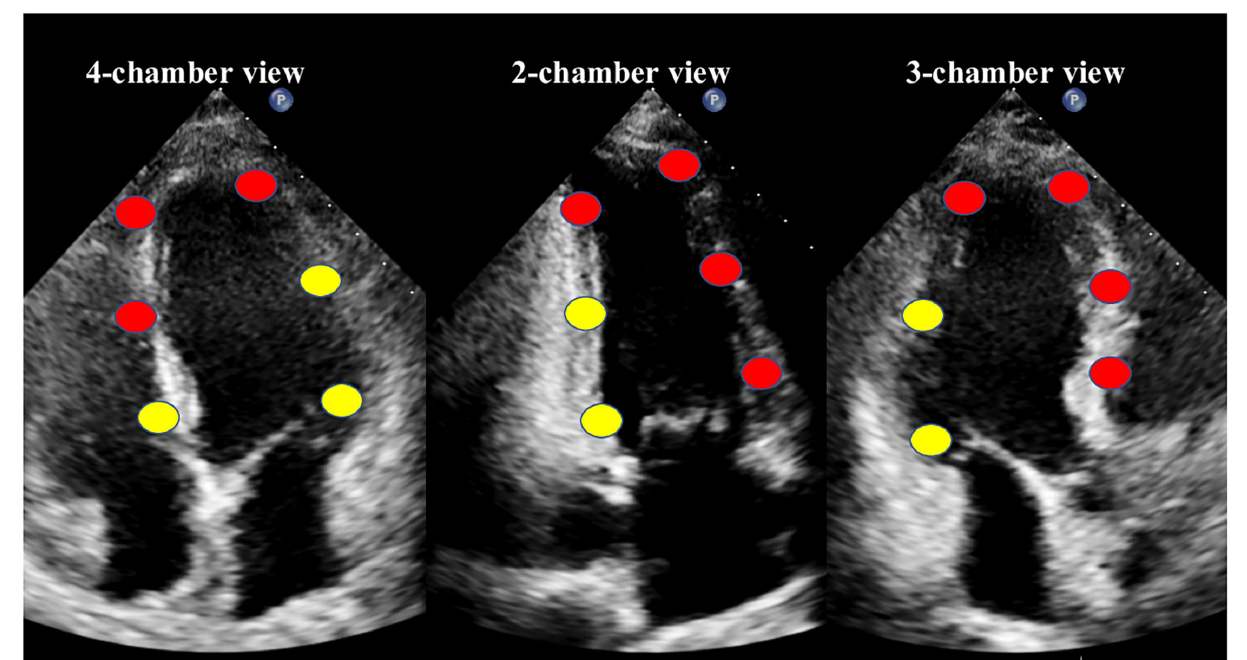
FIGURE 1 | The18-segment model for myocardial work analysis. Red dots indicate the segments of the left anterior descending coronary artery (LAD) territory, while yellow dots indicate the non-LAD territory.